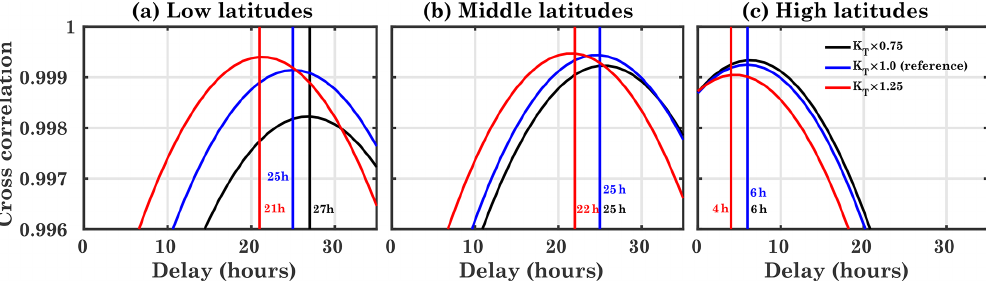
Figure 4. Cross-correlation and the delay between regional mean TEC and the F10.7 index at low (a) , middle (b) , and high (c) geomagnetic latitudes for different